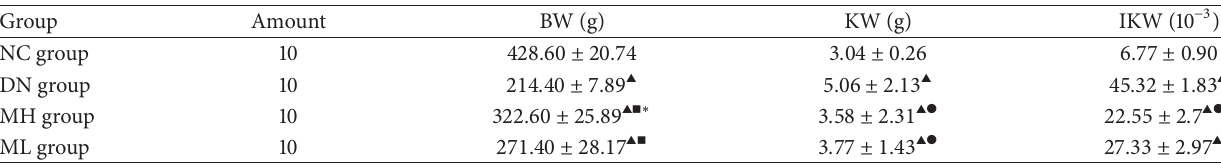
Table 1: Results of Body Weight, Kidney Weight, and Kidney Weight Index. Body weight was lower in the experimental groups compared with the NC group, whereas it was significantly recovered in the MH and ML groups compared with the DN group. Conversely, kidney weight and kidney weight index were greater in the experimental groups, but decreased upon MG132 treatment. Changes in the MH group were more significant than the ML group.